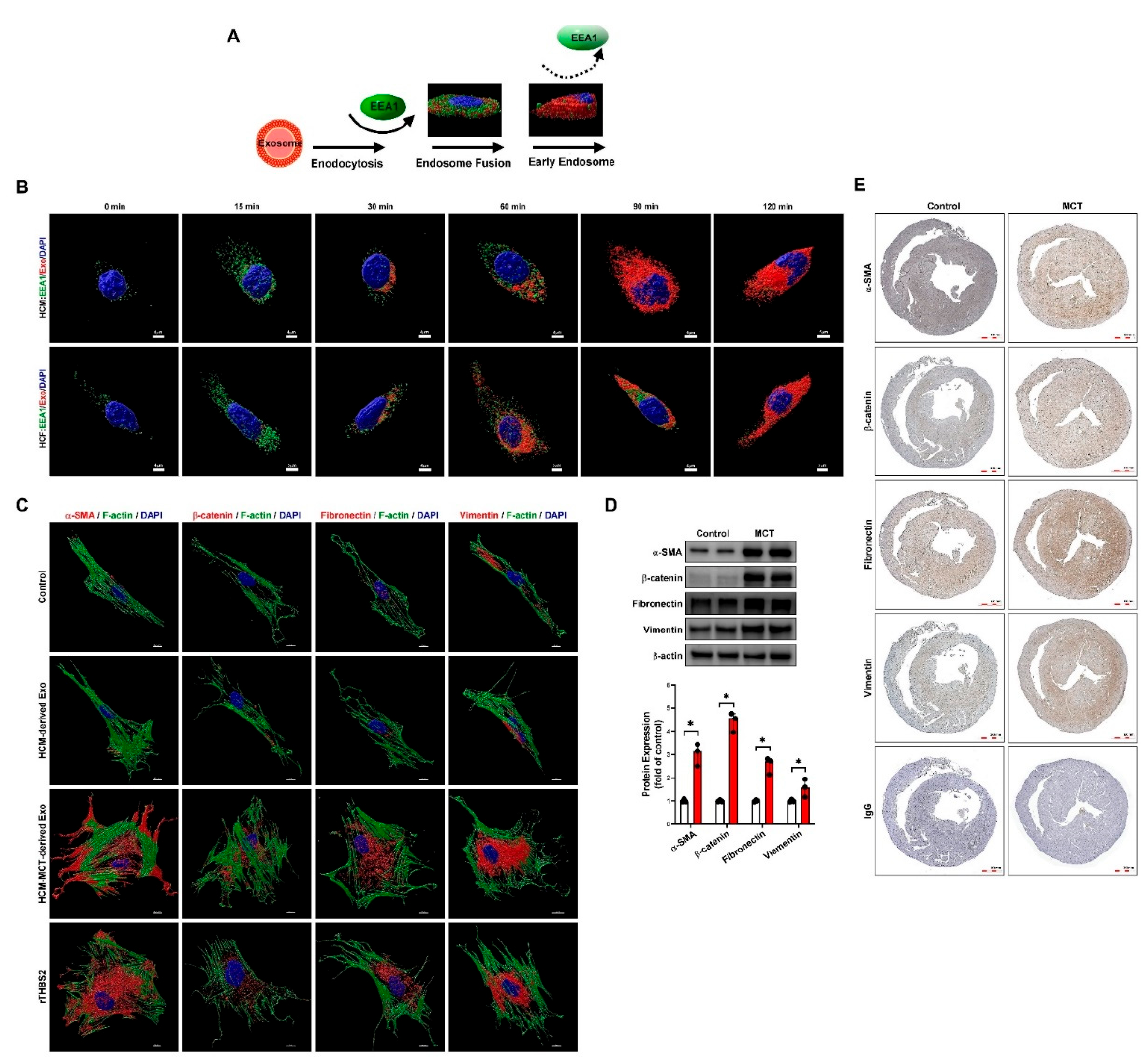
fibroblast to myofibroblast transformation (Figure 6C). The PAH animal model also con- firmed that PAH-induced myofibroblast marker proteins were highly expressed in the myocardial tissue (Figure 6D,E).